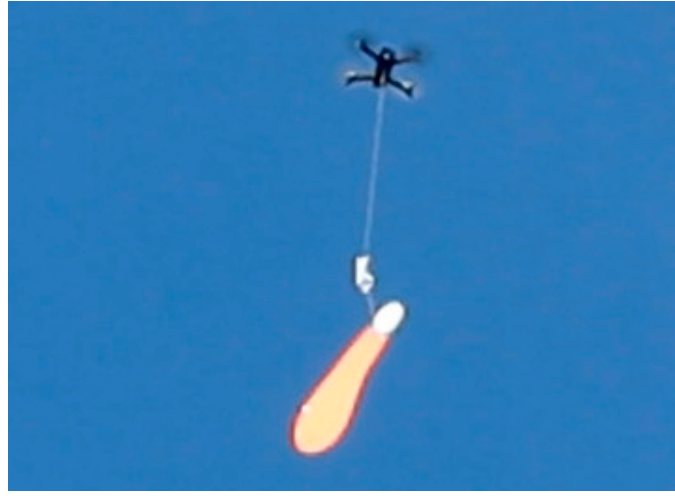
Figure 15. TA2 beneath drone just before release.